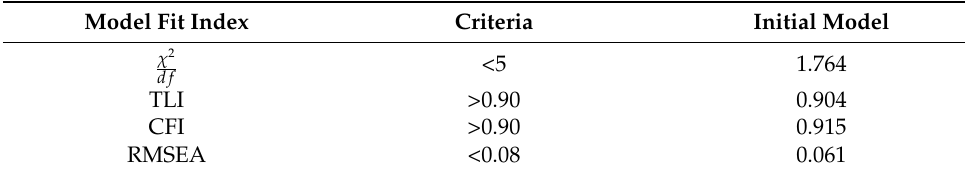
Table 5. Model Fit of Hypothesized